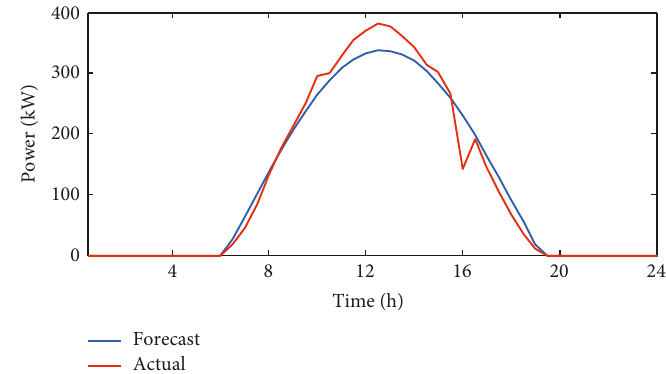
Figure 4: Forecast and actual PV power